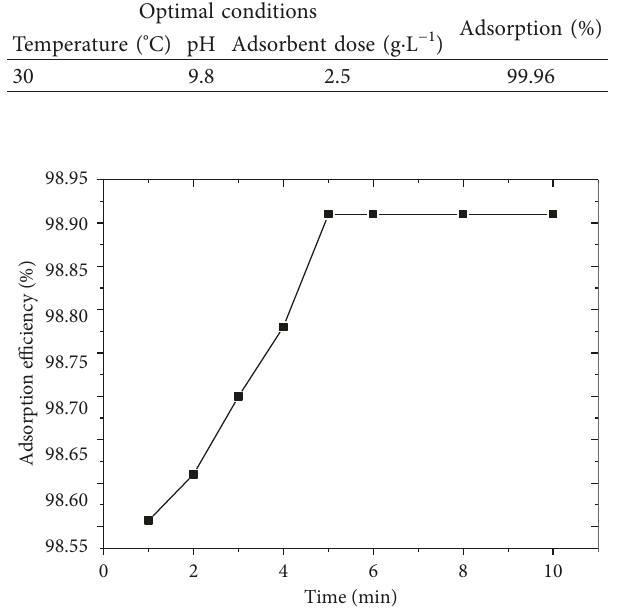
Figure 11: Evolution of the adsorption of DM under optimal